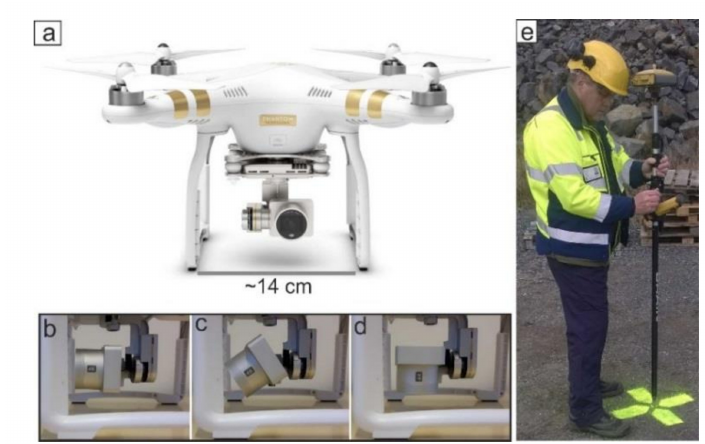
Figure 1. ( a ) Front view of the Phantom 3 Professional. ( b – d ) Showing different camera orientations in horizontal, oblique and vertical positions. ( e ) Photo showing measurement of a ground control point with the Topcon HiPer ® receiver with FC-200 field